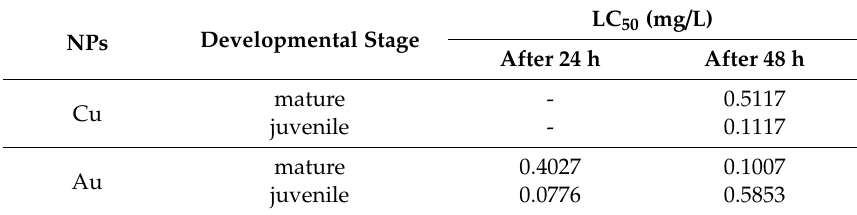
Table 3. LC 50 values calculated for Daphnia pulex after 24 and 48 h